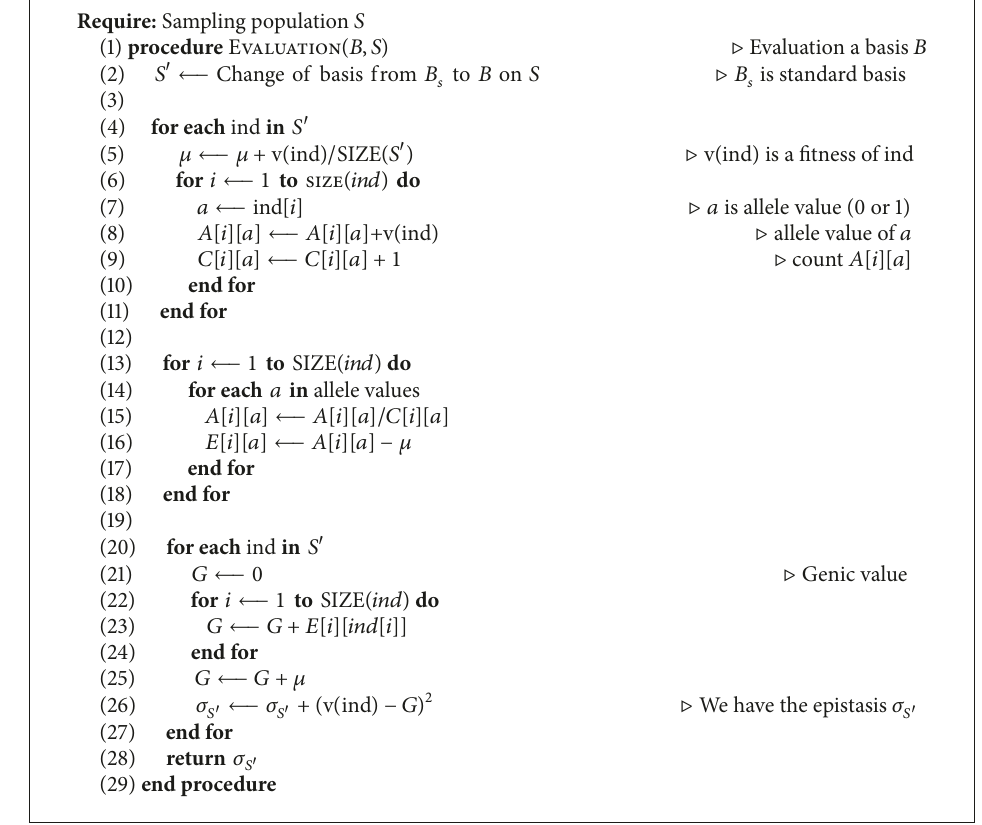
Algorithm 2: Basis evaluation based on